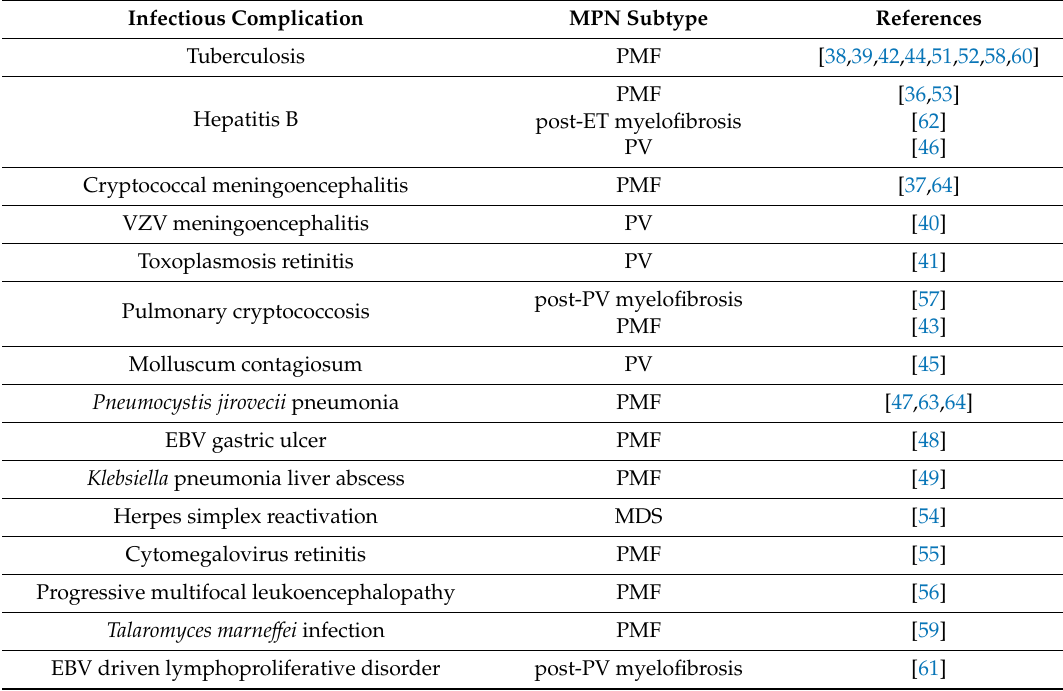
Table 1. Case reports of rare ruxolitinib-associated infectious